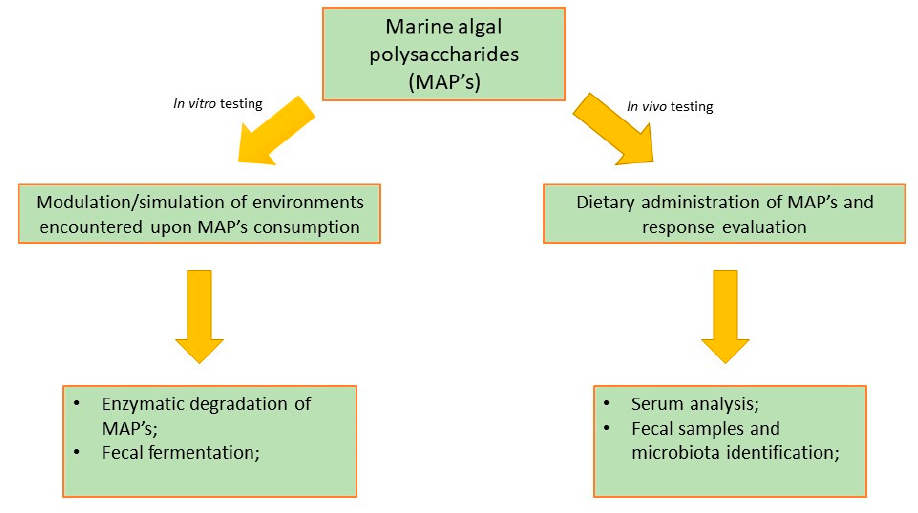
Figure 3. Schematic representation of prebiotic potential analysis using seaweed